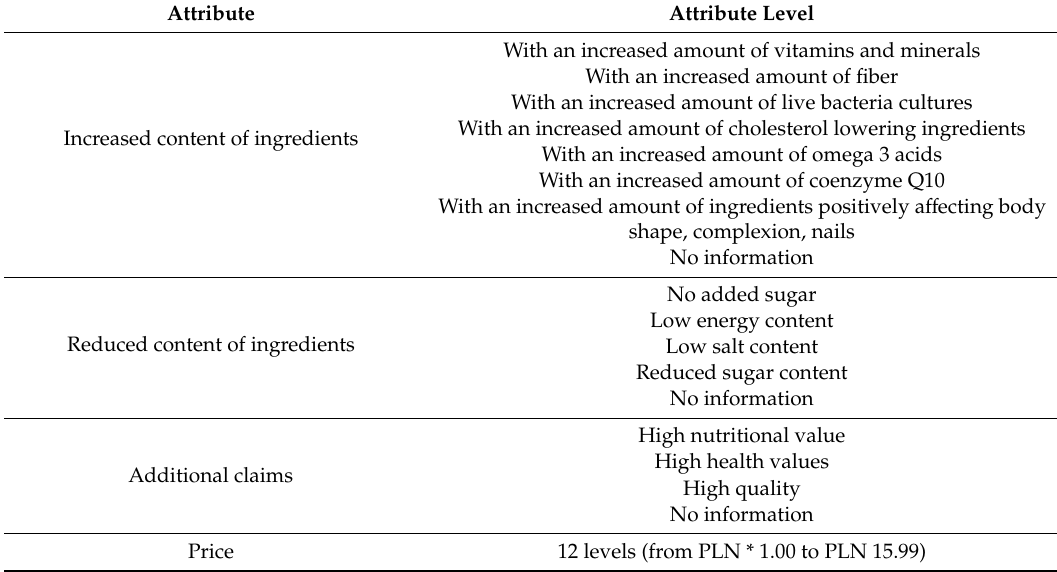
Table 1. Attributes and levels used in the discrete choice-based experiment design.